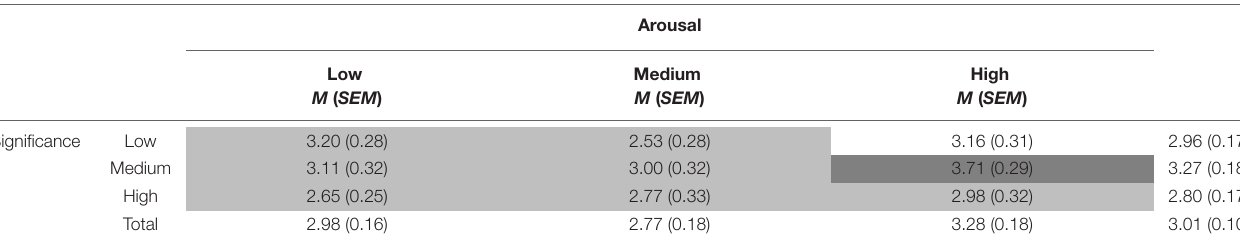
TABLE 5 | Average amplitude of P2 component (in µ V) for each